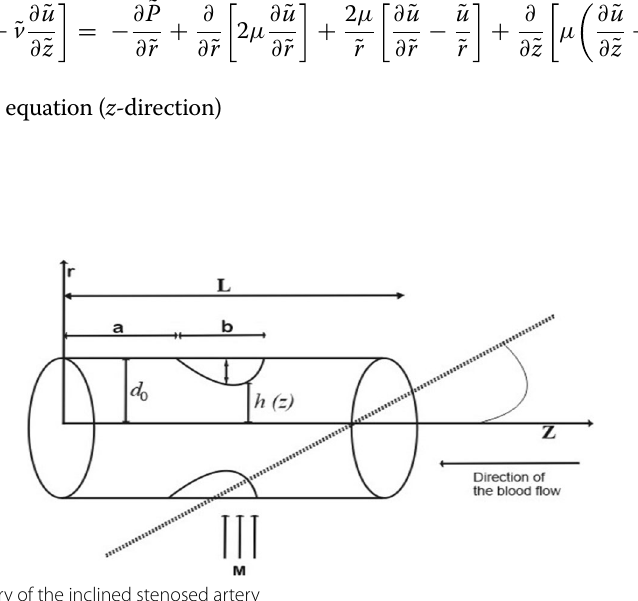
Fig. 1 Geometry of the inclined stenosed